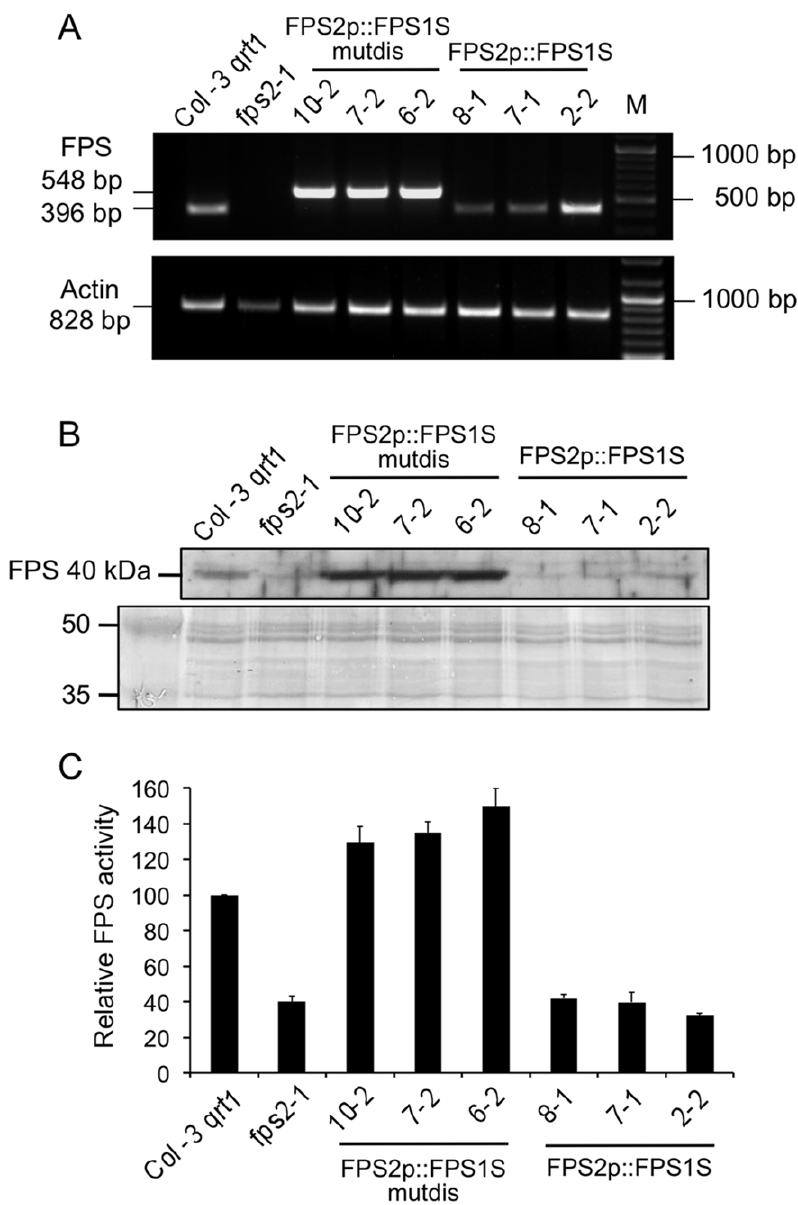
Figure 8. Characterization of fps2-1 mutant lines harbouring FPS2p::FPS1S and FPS2p::FPS1-mutdis genes. (A) The expression of FPS2p::FPS1S and FPS2p::FPS1-mutdis was investigated using total RNA from 12-day-old seedlings of Arabidopsis wild-type, fps2-1 and the indicated lines of the fps2-1 mutant harbouring FPS2p::FPS1S-mutdis and FPS2p::FPS1S chimeric genes (upper panel). PCR products were electrophoresed in a 1% agarose gel. The size in bp of the amplified cDNA fragments corresponding to FPS2p::FPS1-mutdis , FPS2p::FPS1S and ACT2 (actin) genes is indicated on the left. The size of the fragment amplified from FPS2p::FPS1S-mutdis lines (548 bp) was larger than that amplified from both FPS2p::FPS1S lines and wild-type plants (396 bp) because the FPS2::FPS1-mutdis mRNA contains the region between the two ATG translation start codons of the FPS1 gene, which is not present in the FPS2::FPS1S mRNA. Numbers on the right indicate the sizes in bp of DNA markers shown in lane M. (B) Western blot analysis of total FPS protein in 16,000 g extracts from seeds of plant lines indicated above (upper panel). The lower panel shows the Coomassie blue-stained electrophoretic protein patterns in the 35 to 50 kDa range of extracts used for FPS protein level determinations. Images show the results of one representative experiment. (C) FPS activity in the 16,000 g protein extracts used for Western blot analysis. FPS activity in fps mutants is expressed relative to that in the wild-type, which was assigned a value of 100. The mean values and SE were calculated from three independent experiments. doi:10.1371/journal.pone.0049109.g008 FPS2 with GFP in agroinfiltrated N. benthamiana leaf cells. Under FPS1S and FPS2 could harbour a cryptic signal for peroxisomal targeting as recently reported to occur in a C. roseus short FPS our experimental conditions all the four fusion proteins localized exclusively in the cytosol (Figure 5). This result was fully consistent enzyme. In contrast to our results, an N-terminal fusion of CrFPS with the absence of canonical subcellular targeting signals in the with YFP was found to localize both in the peroxisomes and the FPS1S and FPS2 proteins, and argued against the possibility that cytosol of C. roseus cells despite the protein does not contain any